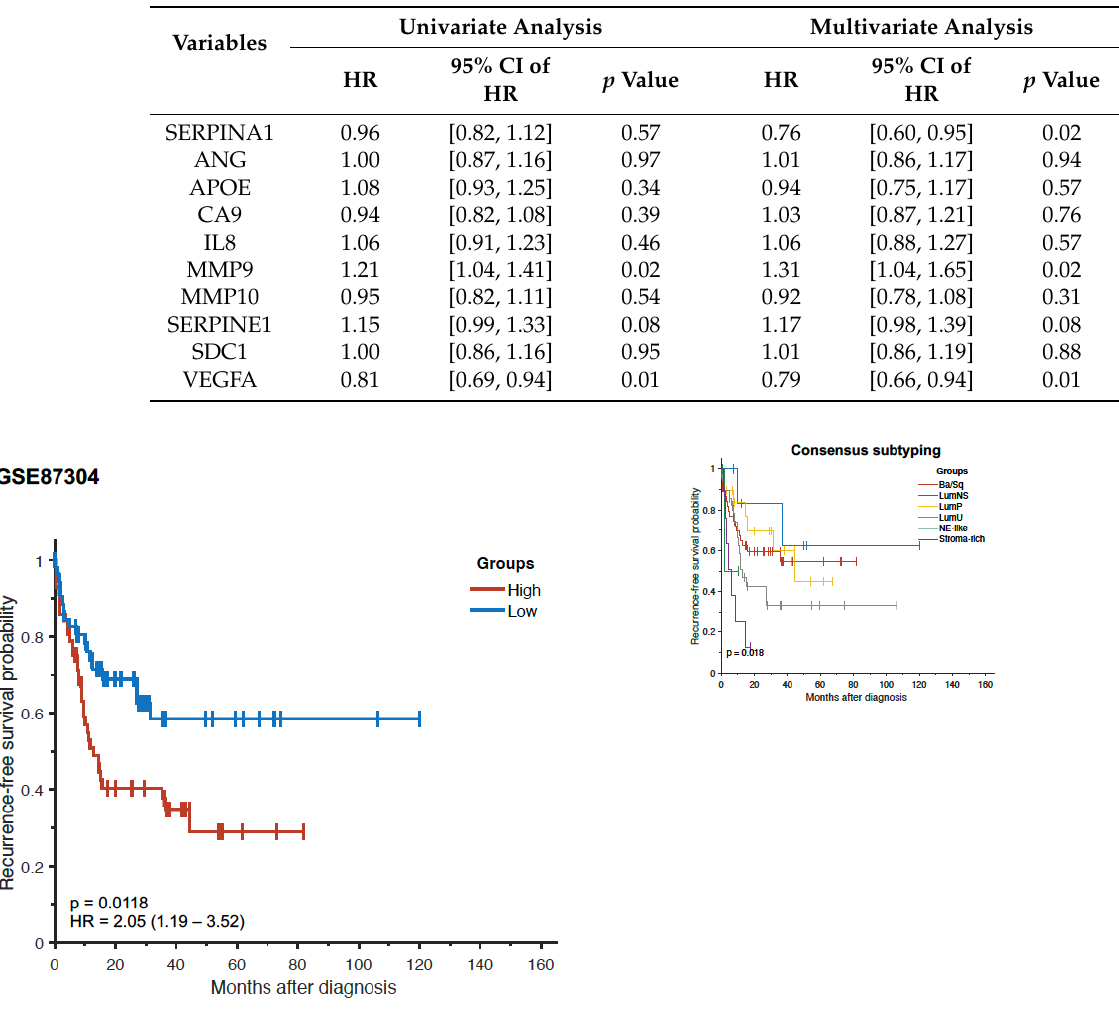
Table 2. Coefficients based on a Cox regression analysis of the 10 Oncuria™ biomarkers.